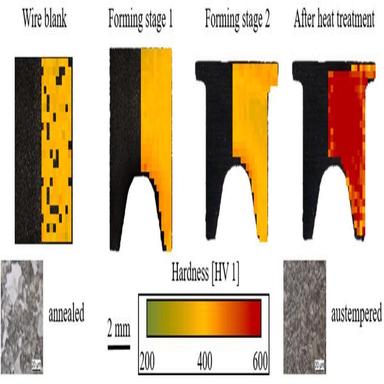
Change in the material hardness during the manufacturing process chain.